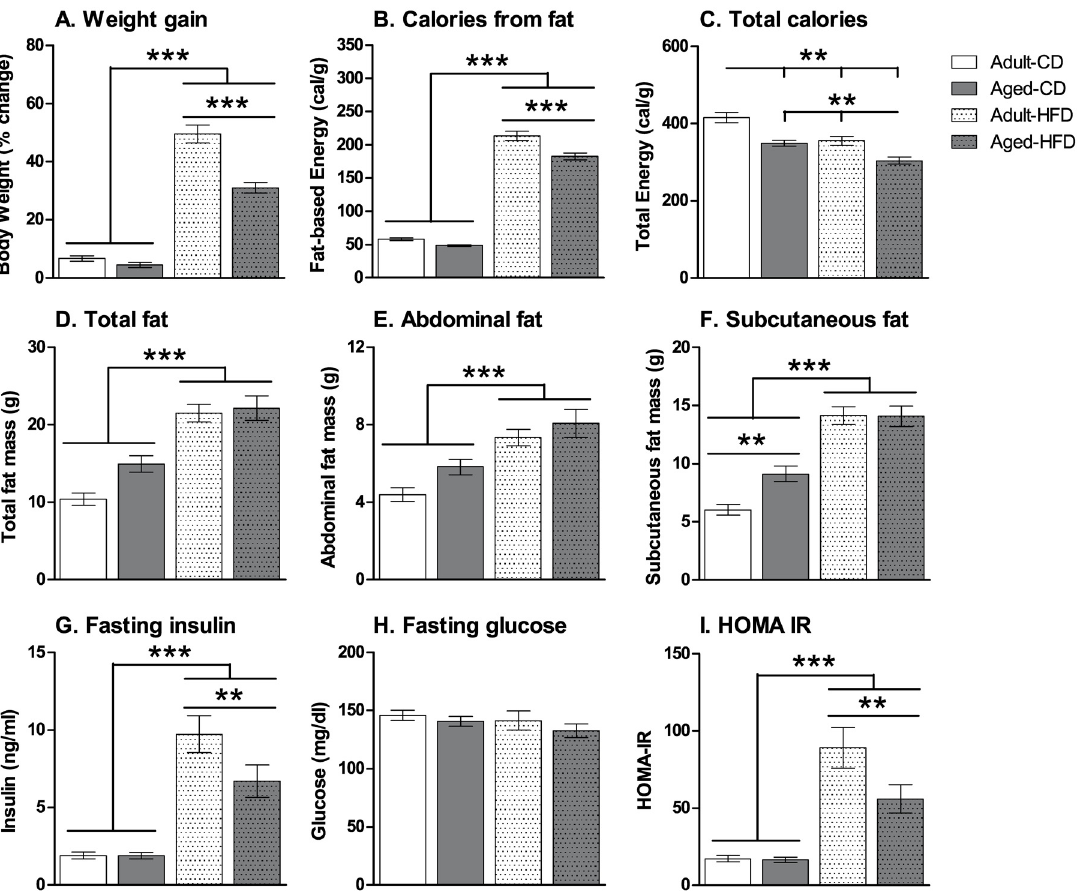
Fig 1. Weight gain, food consumption and physiological effects of aging and exposure to high-fat diet. Top : Weight gain ( A ), daily fat-based energy consumption per gram of bodyweight ( B ) and total energy consumption per gram of bodyweight ( C ) after 2 months on either the control diet (CD) or high-fat diet (HFD). All mice gained substantially more weight when consuming the HFD compared with the CD diet. However, adult mice gained a larger proportion of weight than aged mice when on the HFD ( A ). A similar profile was observed for the fat-based energy consumed per day ( B ) but not with total calorie consumption ( C ) suggesting that weight gain was driven by fat-based energy rather than total calorie consumption. Middle : Total fat mass ( D ), and the contributing amounts of abdominal fat ( E ) and subcutaneous fat ( F ) after 4.5 months on the CD or HFD. Both increased age and HFD exposure led to significantly greater total, subcutaneous and abdominal fat mass. However, aged mice on the CD had significantly higher subcutaneous fat mass than adult mice on the CD whereas no significant effect of age was observed in mice on the HFD. Bottom : Fasting insulin levels ( G ), fasting glucose levels ( H ) and Homeostasis Model Assessment of insulin response (HOMA-IR) ( I ) after 4.5 months on the CD or HFD. HFD exposure led to significantly increased levels of fasting insulin despite similar fasting glucose values, indicating significant HFD-induced insulin resistance as demonstrated by increased HOMA-IR levels. Adult mice on the HFD showed significantly greater fasting insulin levels and HOMA-IR values than aged mice on the HFD suggesting more severe metabolic effects of HFD consumption. The data are expressed as mean ± SEM. * p < 0.05, ** p < 0.01, *** p < 0.001.